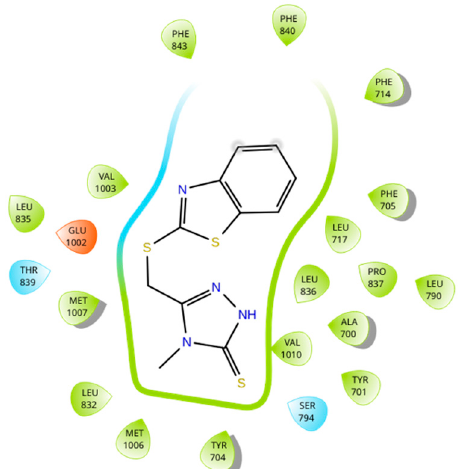
Figure 7. Ligand interaction diagram of 6-MP into MRP4 performed in Maestro. Green: hydrophobic interaction. Blue: polar interaction. Orange: interaction with negative charged residue. Pink arrow: H-bond.